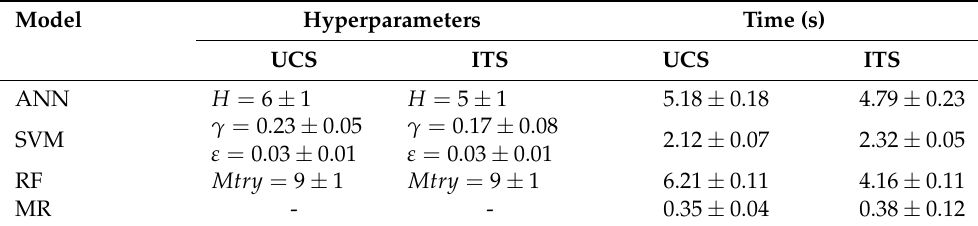
Table 2. Hyperparameters and computation time of each DM model. Model Hyperparameters